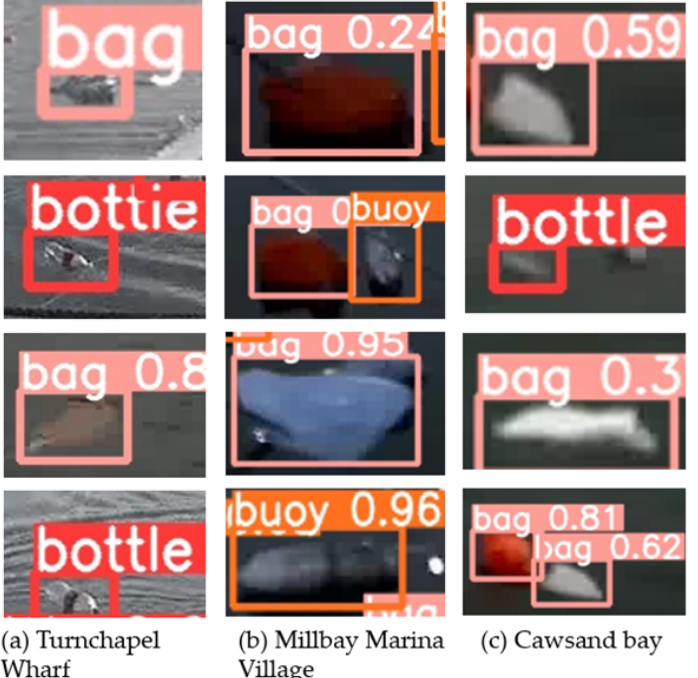
Figure 12. Zoomed in test images from each site showing the plastics detected by the model for each of the three sites ( a ) Turnchapel Wharf, ( b ) Millbay Marina Village, ( c ) Cawsand bay. Percentage Pixels of